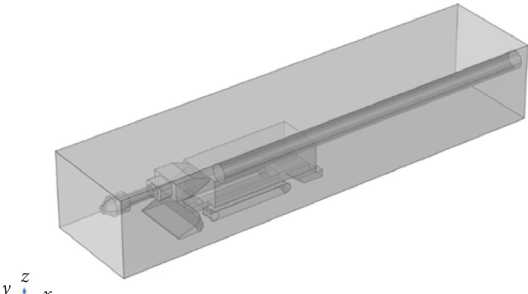
Figure 1: Physical model of the fully mechanized excavation face.